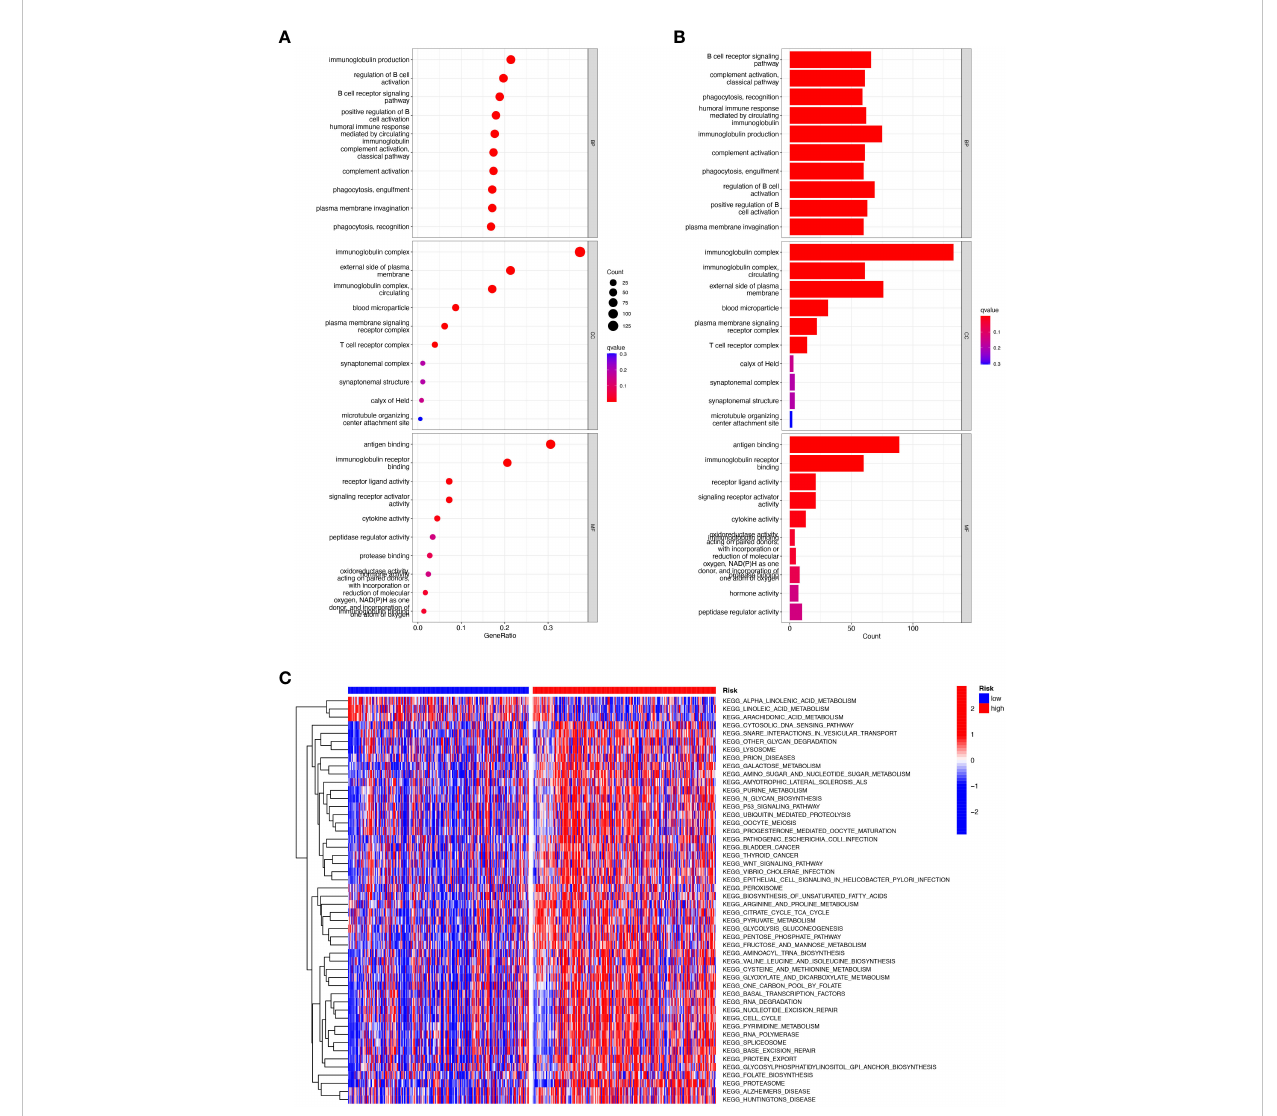
FIGURE 7 Functional enrichment analysis of CRRGs in TCGA-HNSCC. (A, B) Gene Ontology (GO) enrichment analysis was used to analyze the differential genes between HNSCC and normal samples. (C) GSVA analysis between the high-risk cohort and the low-risk